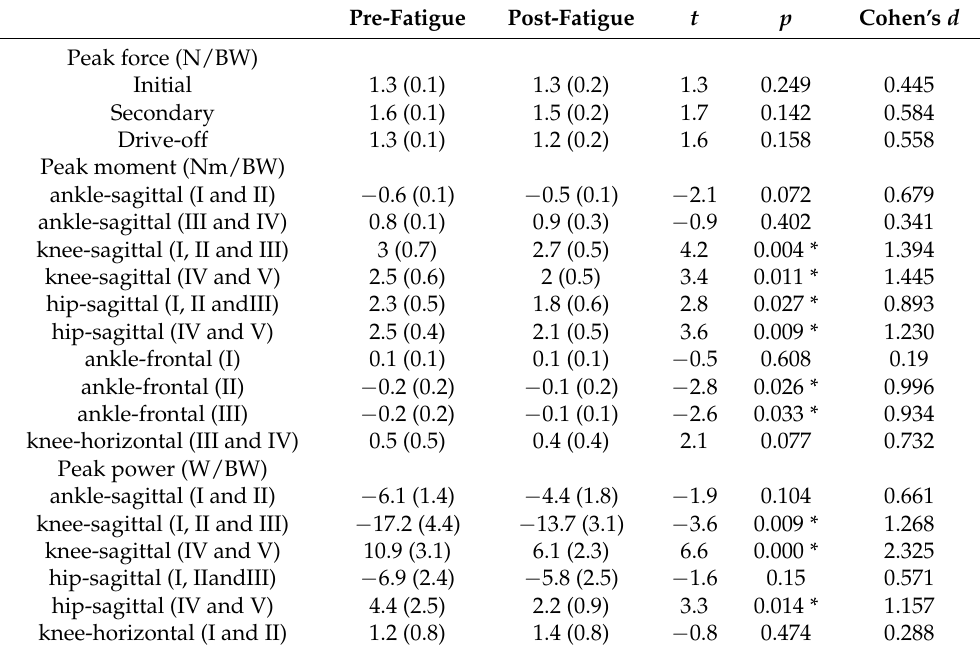
Table 3. Peak force (N/BW), peak moment (Nm/BW) and power (W/BW) (mean ± SD).